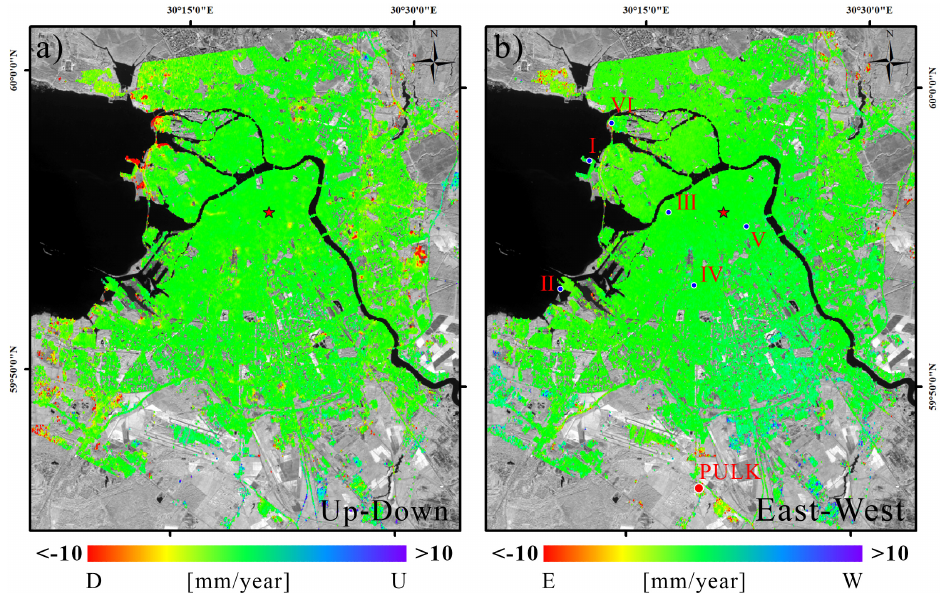
Figure 5. Map of up-down ( a ) and east–west ( b ) mean deformation velocity in Saint Petersburg city center area for 2016–2018. The red point, labelled “PULK” in ( b ), is a GPS station (refer to [17]). In addition, cross-validation of the InSAR results with the external GPS (location highlighted in Figure 5) measurements has been performed, and the validation result is shown in Figure 6. The root means square errors (RMSEs) between the measured displacement and the InSAR derived displacements are 3.7 mm for the up-down deformation components and 2.6 mm for the east–west components, respectively.